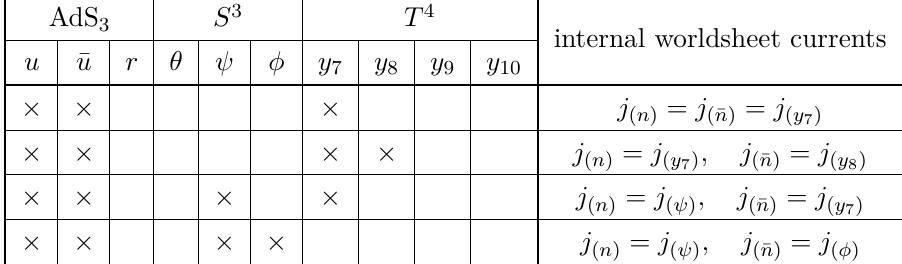
Table 1. Different choices of TsT coordinates corresponding to the single-trace T deformation. Two of the TsT coordinates are always taken along the lightcone u and ¯ u coordinates of AdS as these correspond to the T and ¯ T parts of the 3